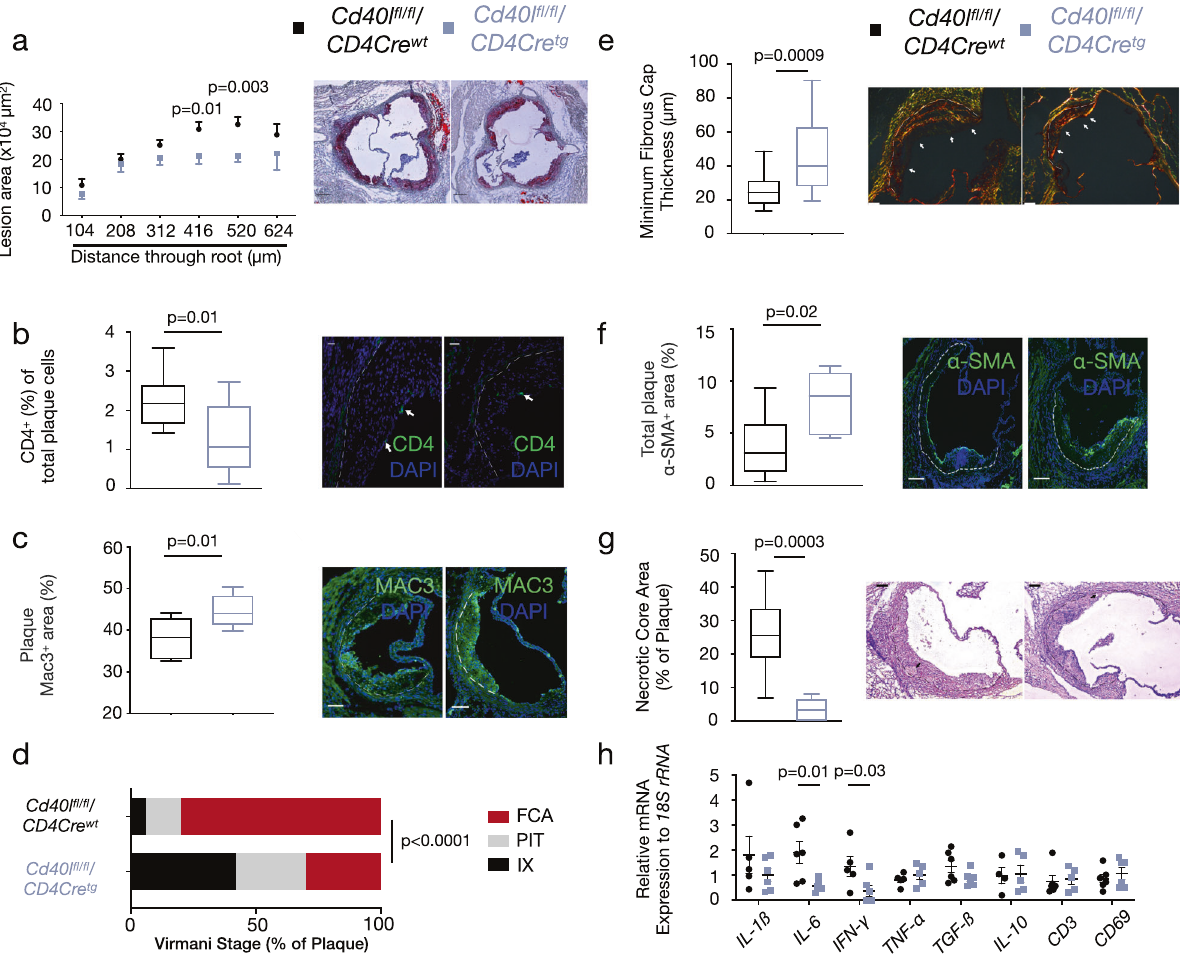
Fig. 1 Lack of T cell CD40L reduces plaque burden with less advanced, more stable plaques. a Atherosclerotic plaque area in cross-sections at indicated positions of the aortic root from Cd40l fl / fl /Cd4Cre mice [ n : WT = 17, TG = 16] with representative Oil Red O-stained photomicrographs (scale